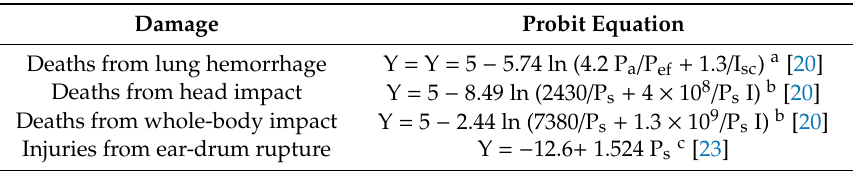
Table 3. Probit functions for damage caused by